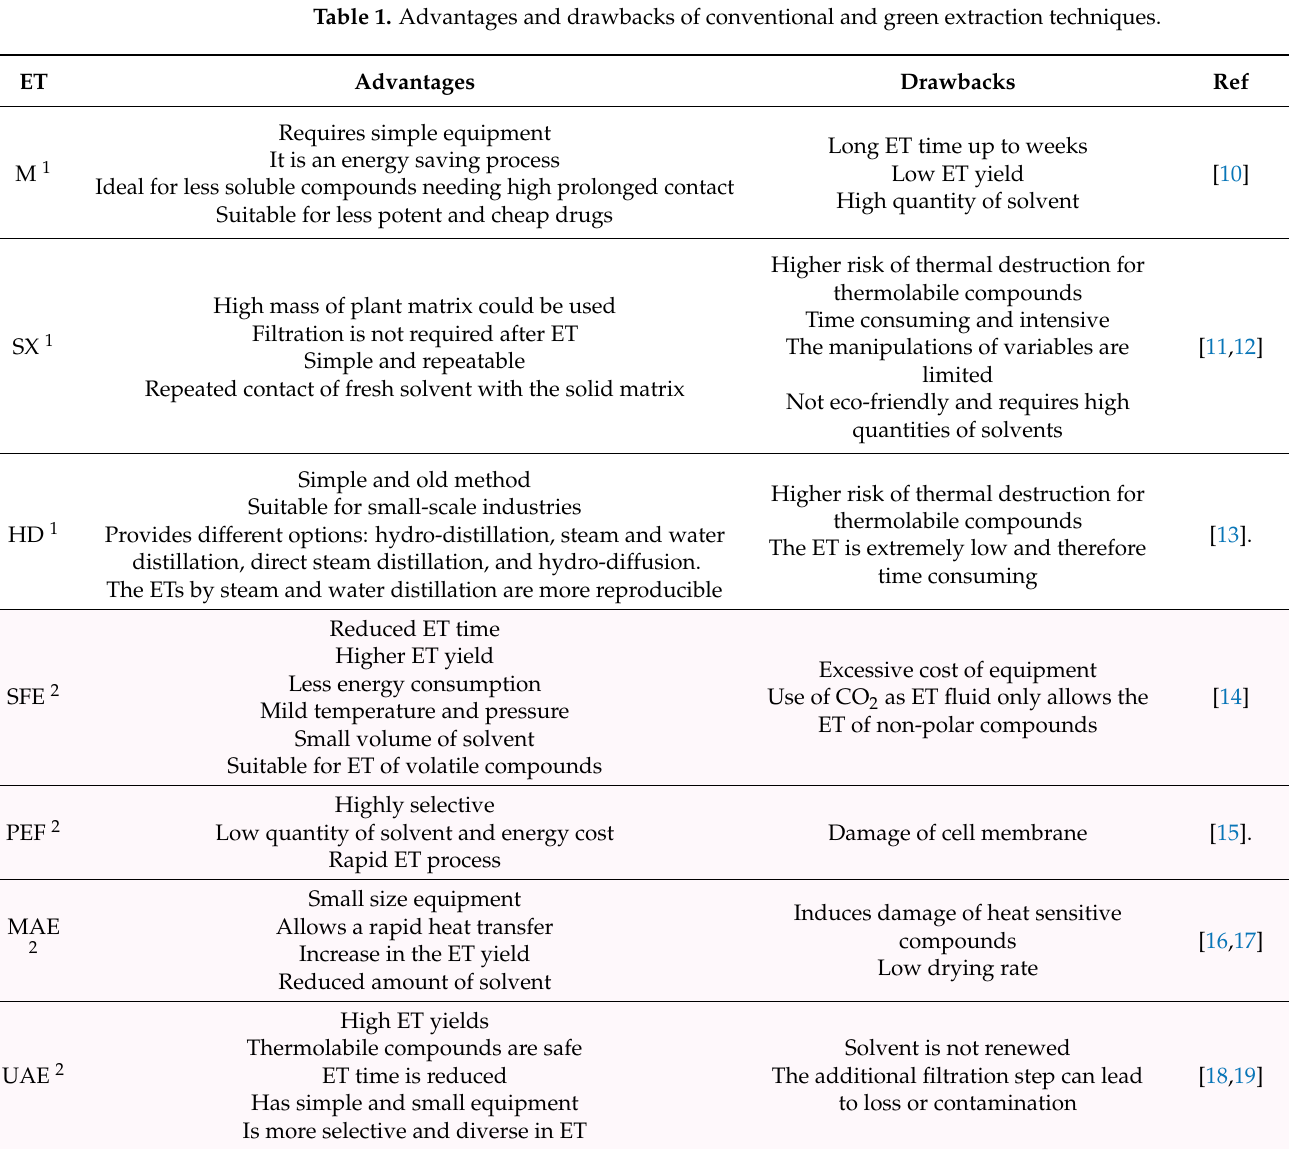
Table 1. Advantages and drawbacks of conventional and green extraction